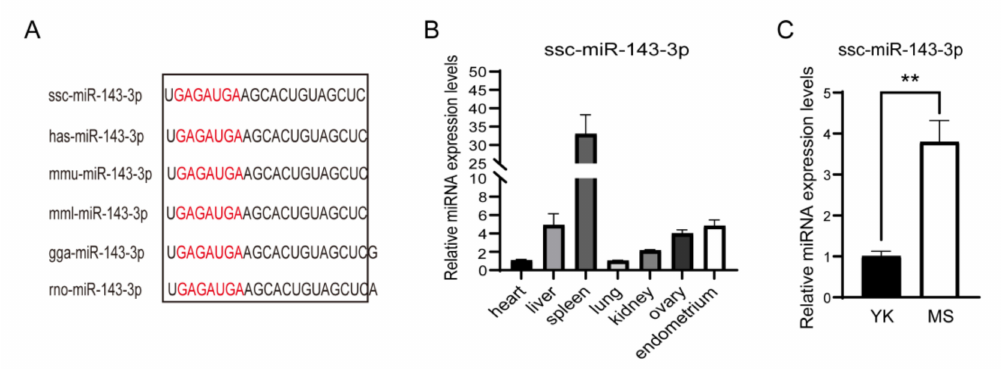
Figure 2. The expression characteristics of ssc-miR-143-3p. ( A ) Mature sequences of miR-143-3p showed that miR-143-3p was conserved across different species. ( B ) The expression characteristics of ssc-miR-143-3p in pig tissues. ( C ) Differential expression of ssc-miR-143-3p derived from extracellular vesicles in uterine luminal fluid (ULF-EVs) in Meishan and Yorkshire pigs. YK: Yorkshire pigs, MS: Meishan pigs. ** p <